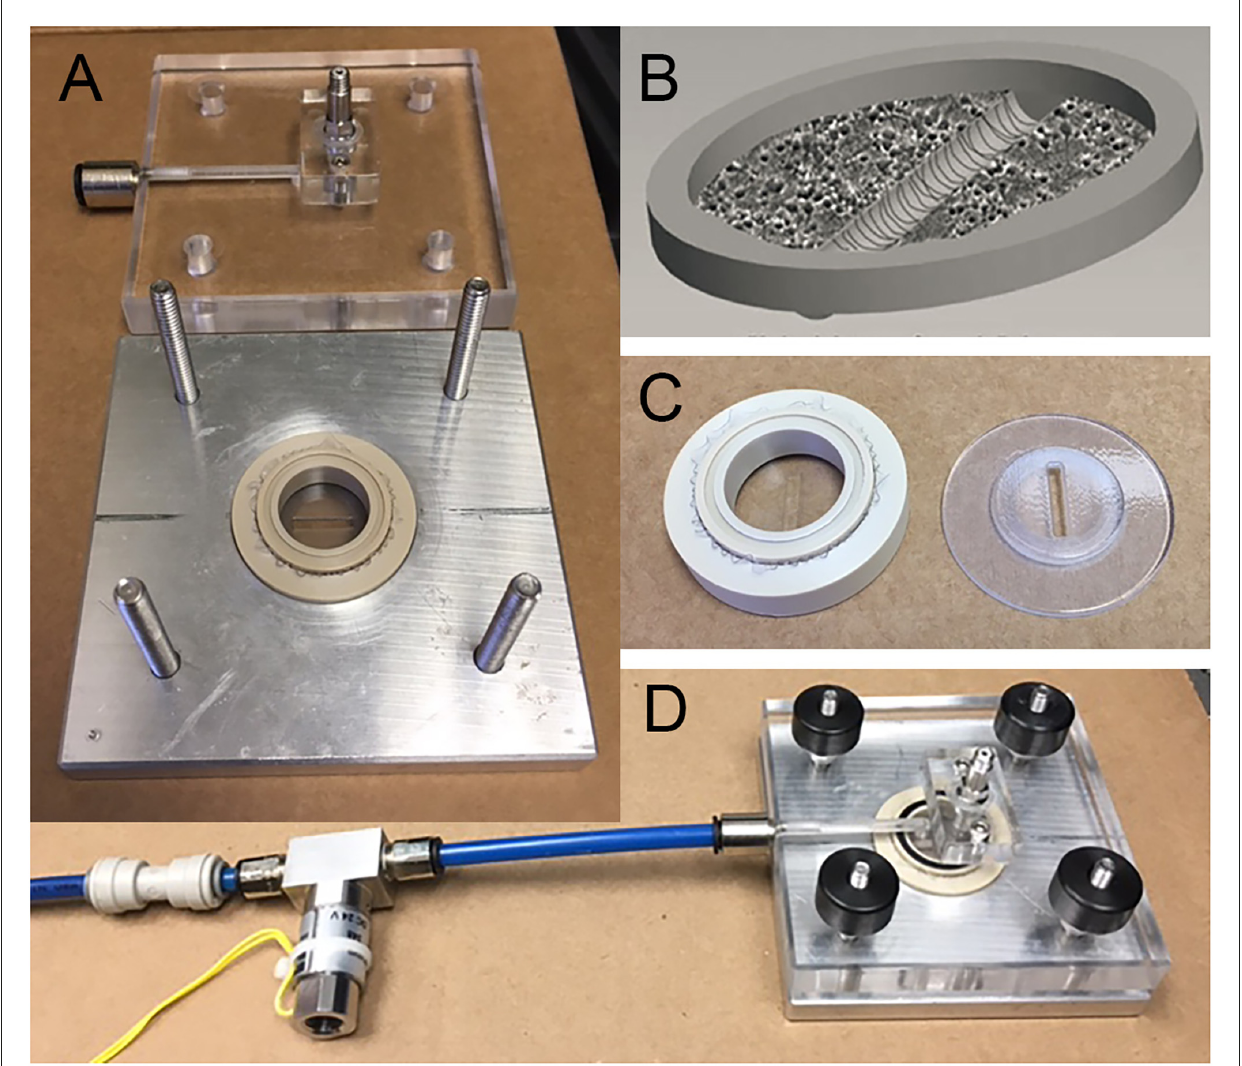
FIGURE1 Axonal stretch injury. (A) Injury device pressure chamber and culture well. (B) Neuronal cultures are grown on a silicone elastic membrane. A region of isolated axons is formed by creating a 2 mm cell free strip across the culture. During the development of the cultures, DRGN and cortical axons transverse the cell free gap. (C) Uniaxial stretch of axons is achieved by placing a rigid mask under the silicone membrane to allow deformation to only the 2 mm strip of axons. (D) Assembled stretch injury